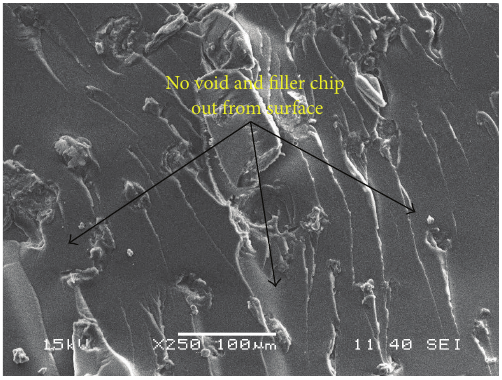
Figure 9: SEM of 15 wt% flexural